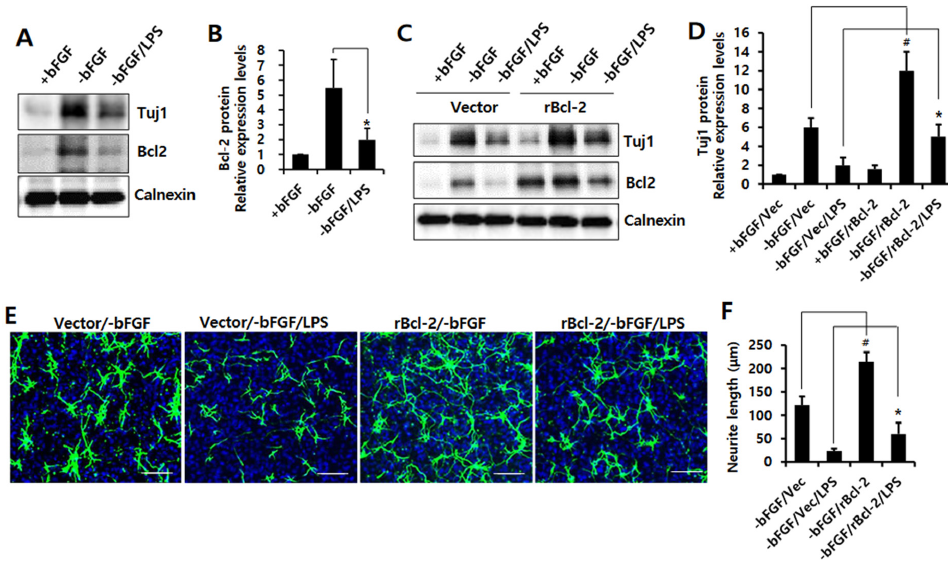
Figure 2. Effect of Bcl-2 overexpression on LPS-induced neuronal damage in NSCs. ( A , B ) NSCs were treated with LPS (1 µ g/mL) for 1 day in the absence of bFGF. ( A ) Western blotting was performed using anti-Tuj1, anti-Bcl-2, or anti-calnexin antibodies to detect the respective protein bands. ( B ) Band intensity was quantified with Quantity Ones ® software. Data are shown as means ± SD. * p < 0.05 compared with –bFGF control. ( C , D ) MSCV-IRES-EGFP or rBcl-2 -MSCV-IRES-EGFP was transfected into the NSCs for 48 h, then the cells were treated with LPS (1 µ g/mL) for 1 day in the absence of bFGF. ( C ) Western blotting was performed using anti-Tuj1, anti-Bcl-2, or anti-calnexin antibodies to detect the respective protein bands. ( D ) Band intensity was quantified with Quantity Ones ® software. Data are shown as means ± SD. * p < 0.05 compared with –bFGF/Vector/LPS control. # p < 0.05 compared with –bFGF/Vector control. ( E , F ) MSCV-IRES-EGFP or rBcl-2 -MSCV-IRES-EGFP was transfected into the NSCs for 48 h, and the cells were treated with LPS (1 µ g/mL) for 3 days in the absence of bFGF. The NSCs were stained with anti-Tuj1(green) and DAPI (blue). Scale bar: 100 µ m. ( F ) Neurite lengths were measured in randomly selected fields using three independent experiments; n = 3 per group. Data are shown as means ± SD. * p < 0.05 compared with –bFGF/Vector/LPS control. # p < 0.05 compared with –bFGF/Vector control. Statistical significances were assessed by one-way ANOVA with a post hoc Tukey’s